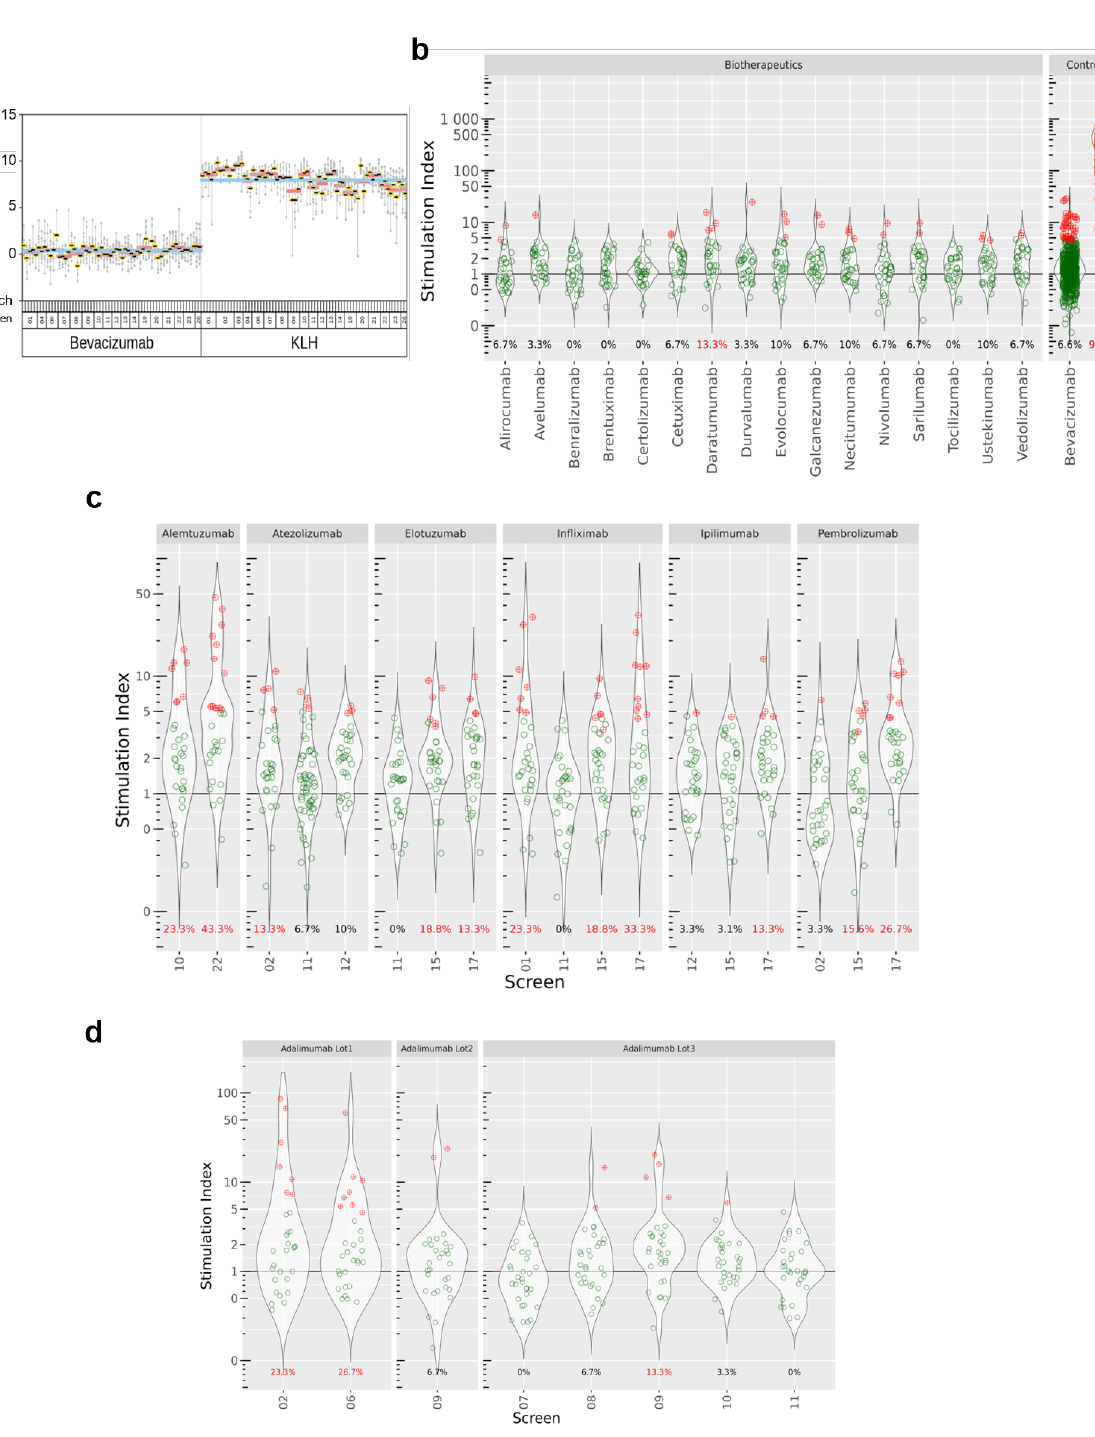
Figure 2. Overview of the stimulation indexes (SI) obtained in the DC:CD4+ T cell restimulation assay. ( a ) Stability of the controls over different assay screens and donor batches. Data were generated for the set of benchmark compounds in single ( b ) or multiple screens ( c , d ). SI represents the number of IFN-γ positive cells over baseline. If a datapoint is significantly above the SI threshold of 2, the donor is considered as positive for this condition and appears in red.